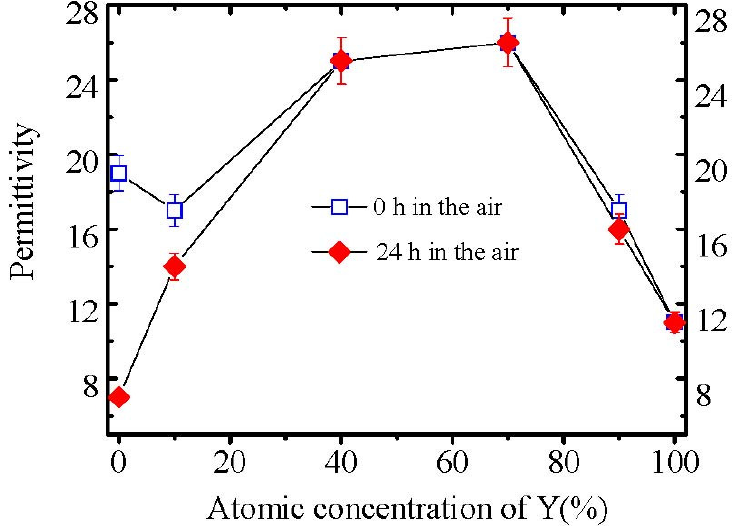
Figure 5. Variation of the permittivities of La permittivities were determined by MIM